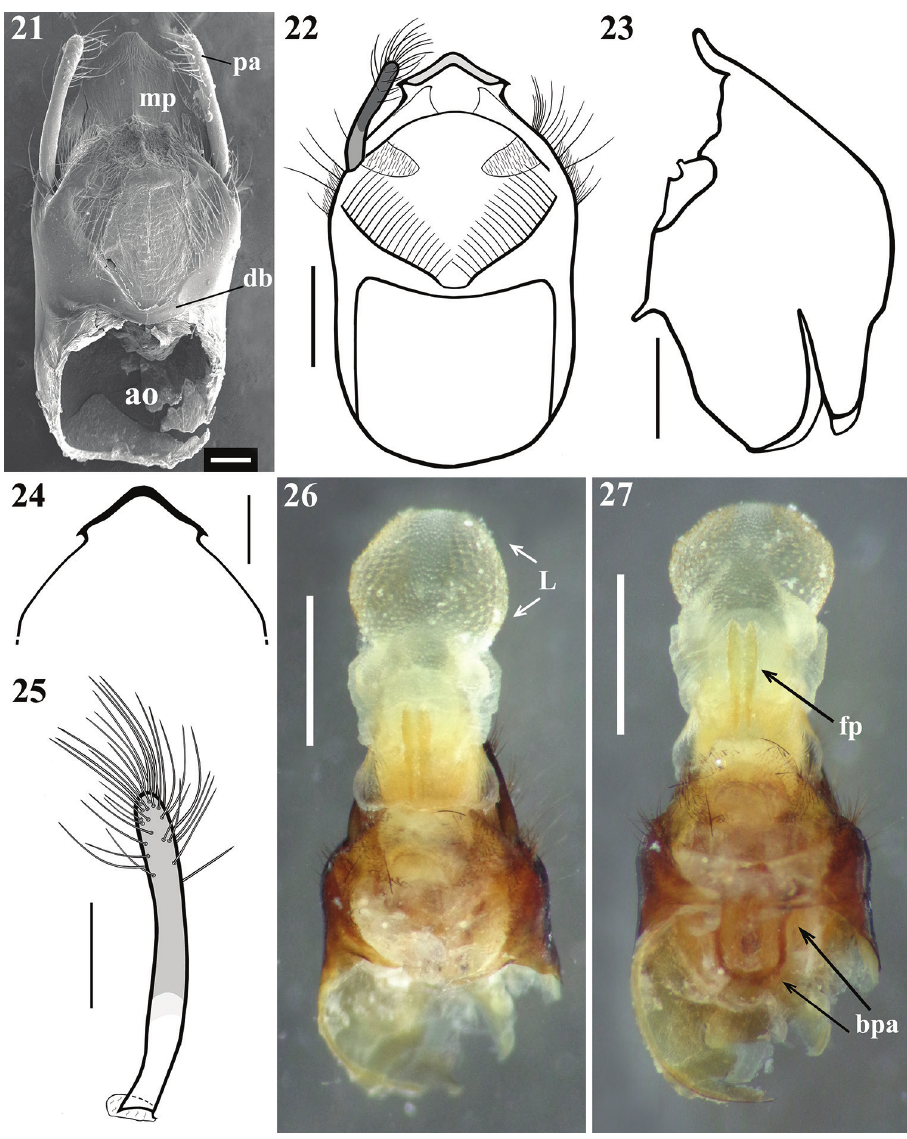
Figures 21–27. Parahiranetis salgadoi Gil-Santana, male genitalia. 21 dorsal view 22 pygophore and right paramere, dorsal view 23 pygophore without parameres, lateral view 24 shape of median process of pygophore, ventral view 25 left paramere 26–27 pygophore with endosoma completely inflated, dorsal view. ( ao : anterior opening; bpa : basal plate arm; db : dorsal bridge; fp : pair of elongate, flat processes; L : globe-shaped lobe in distal third of endosoma; mp : medial process of pygophore; pa : paramere). Scale bars: 0.2 mm ( 21 ); 0.5 mm ( 22–23 ); 0.3 mm ( 24–25 ); 1.0 mm ( 26–27